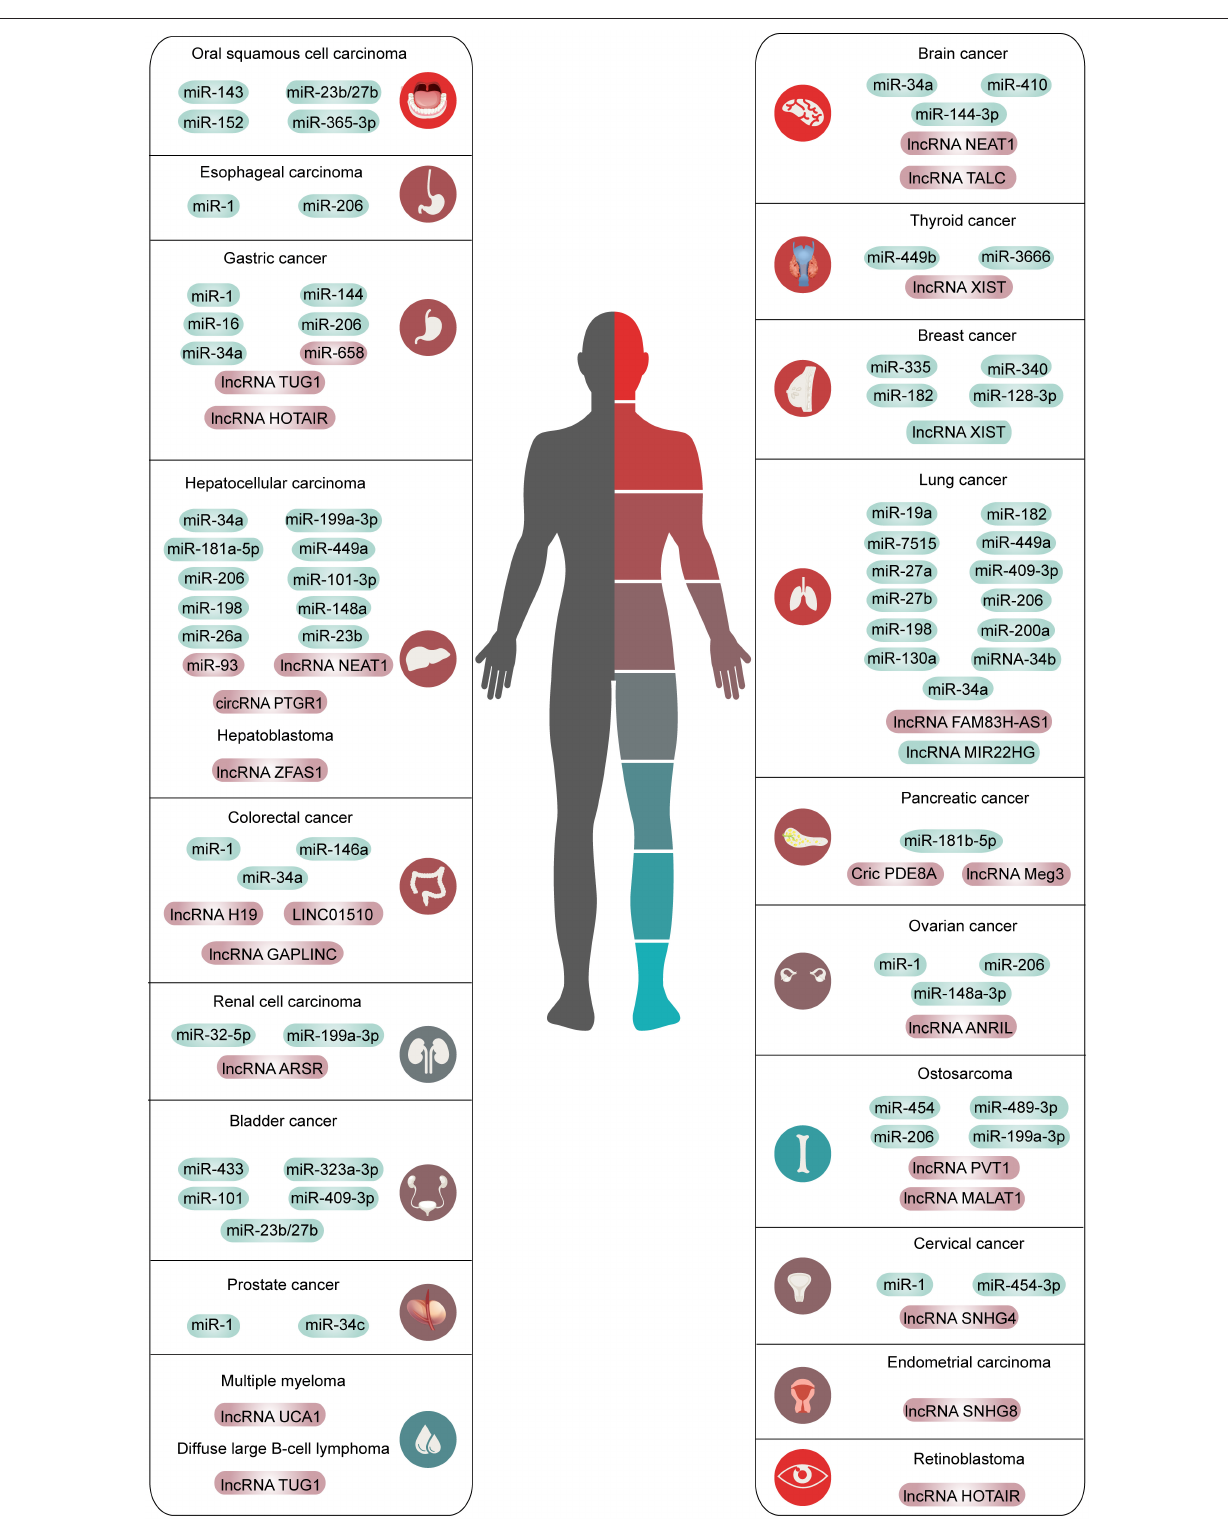
Frontiers in Cell and Developmental Biology |